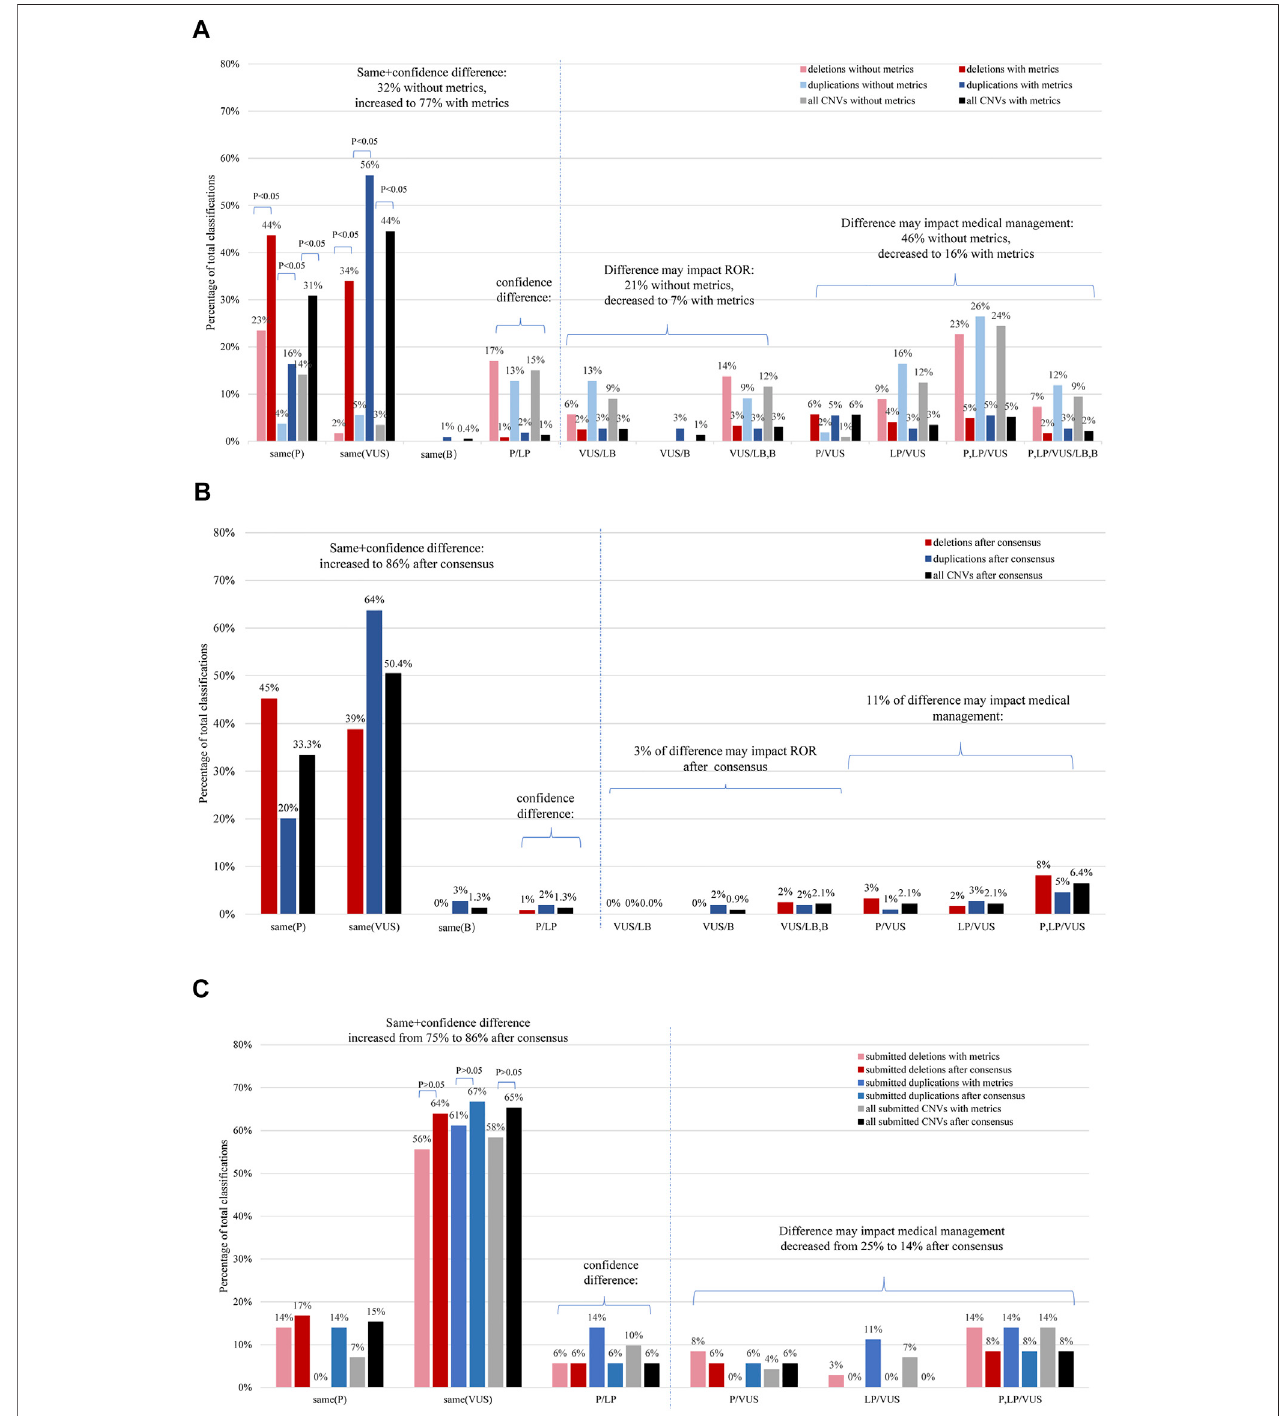
FIGURE 1 | Distribution of CNV classi fi cation comparisons according to the extent of differences using the CNV scoring metrics. (A) Inter-laboratory concordance of the distributed CNVs. The graph illustrates a comparison of the percentage of classi fi cations of the same CNVs, based on either the original data or those obtained using the CNV scoring metrics (N = 234). (B) Inter-laboratory classi fi cation concordance of deletions and duplications which underwent further evaluation for the distributed CNVs (N = 234). (C) The inter-laboratory classi fi cation concordance ofdeletions and duplications was compared before and after conduction offurther evaluationforthesubmittedCNVs(N=72).Theresultsareshownfordeletions(red),duplications(blue),andforallCNVscombined(grayorblack).ROR,returnofresult; P, pathogenic; LP, likely pathogenic; VUS, uncertain signi fi cance; LB, likely benign; B, benign. Con fi dence difference implies that the classi fi cation difference does not affect medical management. * p < .05 means there was a statistical difference.